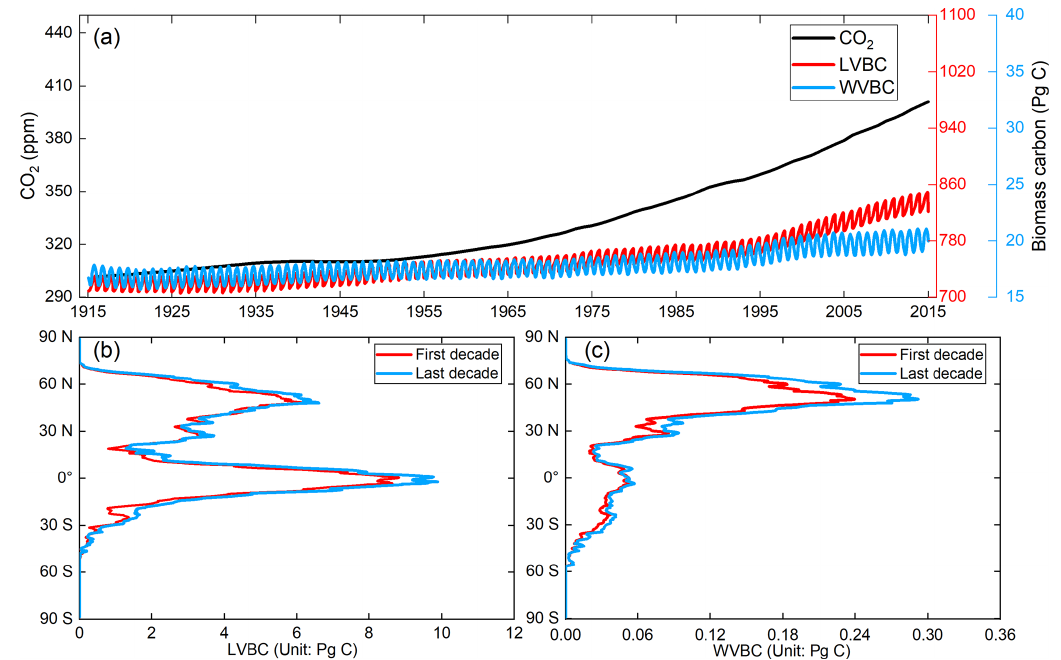
Figure 6. Global potential biomass carbon stocks of vegetation during the past 100 years. (a) The evolution of global potential biomass stocks (LVBC + WVBC), along with changes in biomass stocks that can be attributed to the variability and trend of LVBC and WVBC through the 20th century. The red line represents the monthly value of LVBC, the blue line represents the monthly value of WVBC, and the black line represents the annual value of CO 2 concentration. (b, c) Zonally averaged sums of the annual LVBC and WVBC for latitudinal bands during the first decade (1916–1925, red line) and the last decade (2006–2015, blue line) show the increased carbon stock capacity.